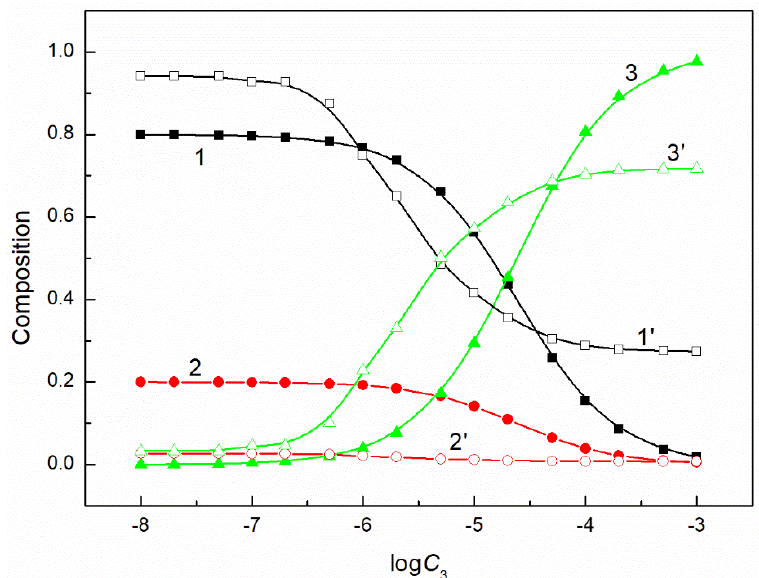
Figure 8. A plot of the composition of the ternary mixture including CTAB, TX100 and FC2 in the monolayer (curves 1–3) and in the bulk phase (curves 1’–3’) at the constant C 12 and γ LV = 50 mN/m vs. the logarithm of the FC2 concentration ( logC 3 ). Curves 1, 1’ correspond to CTAB, curves 2, 2’ correspond to TX100 and curves 3–3’ to FC2.